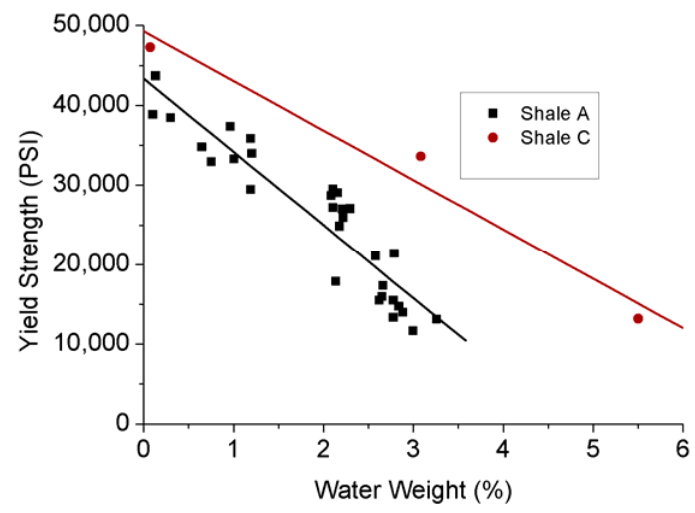
Figure 8 . Relationship between yield strength and water content of shale samples [77].